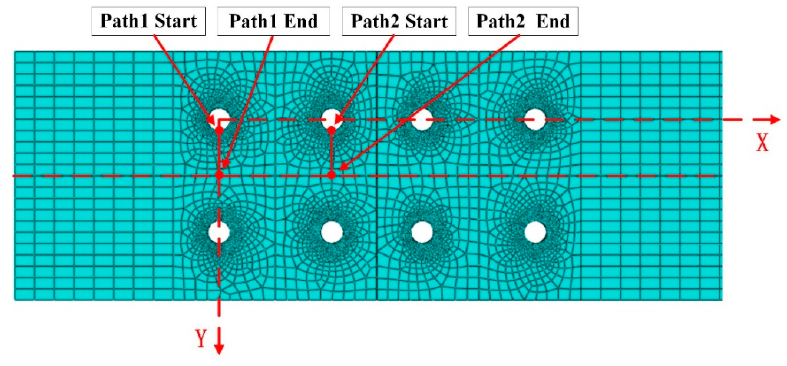
Figure 12. Two paths between adjacent rivets for residual stress distribution investigation.